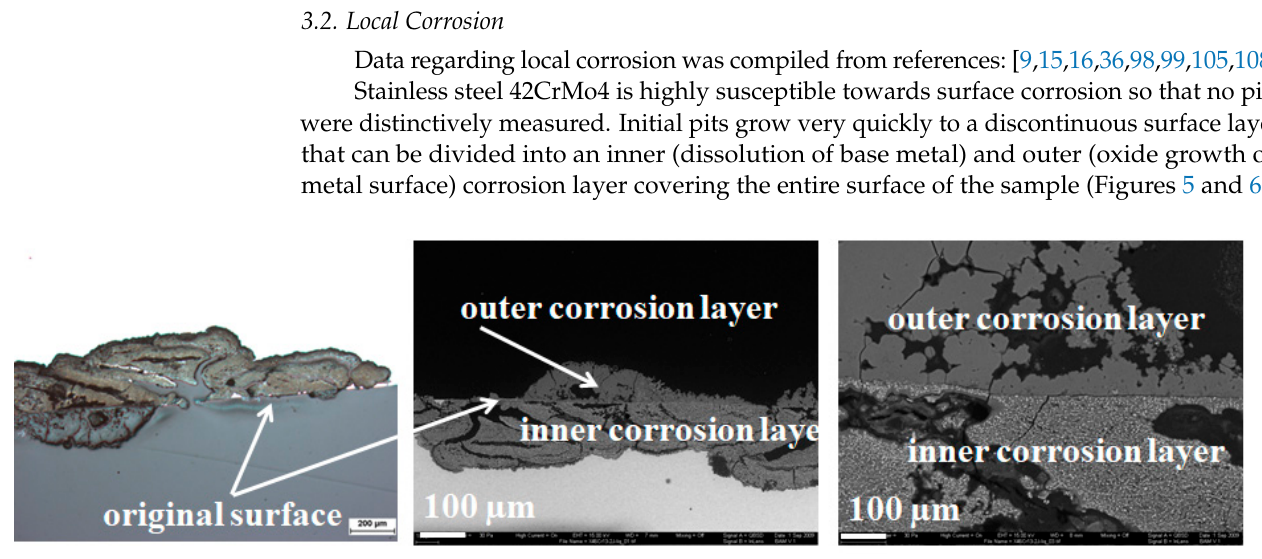
Figure 5. Surface precipitation on 42CrMo4 after exposure to CO 2 saturated saline aquifer water for 8000 h at ambient pressure and 100 bar. ( Top left and right ): Cross section (vapor), ( bottom left ): Vapor, ( right ): Liquid.